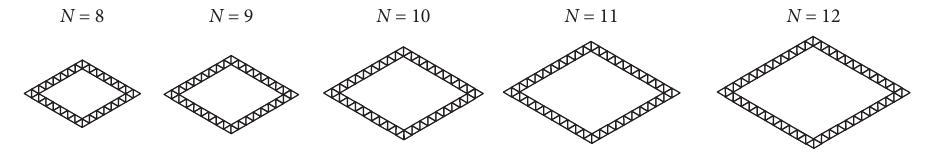
Figure 11: Schematic diagram of DHHs when N � 8 ∼ 12. Table 1: The quasi-static collapse stress of DHHs under uniaxial compression in the x direction, N � 8 ∼ 12 and ρ � 5%.